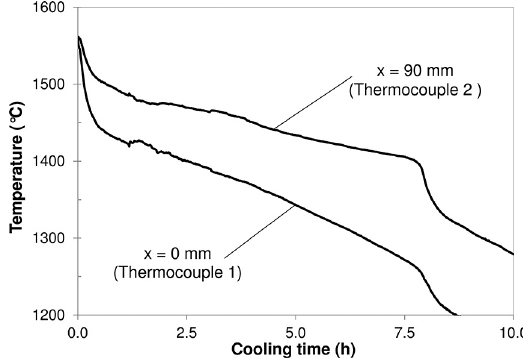
Figure 3. Cooling curves measured directly in the silicon melt during the transient directional solidification